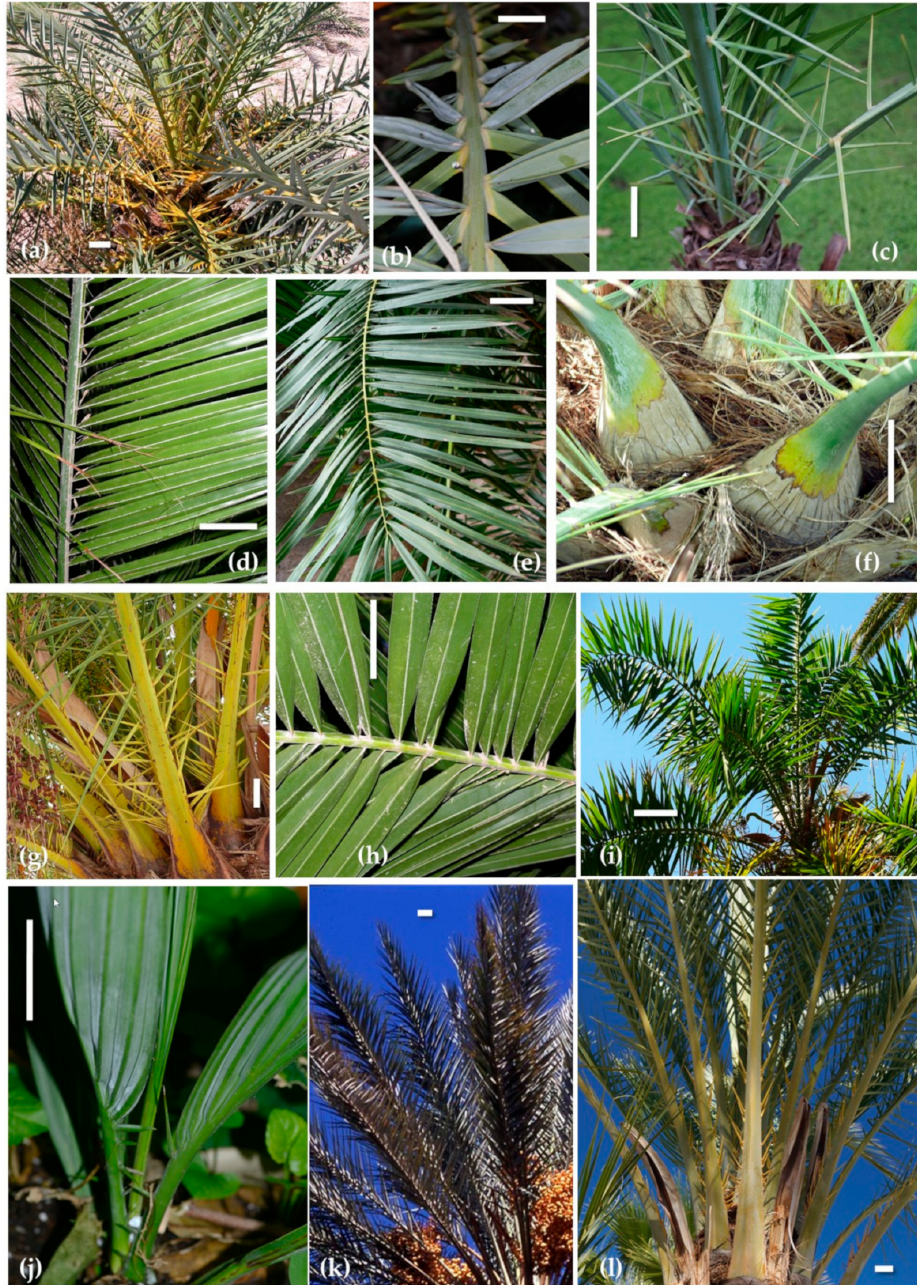
Figure 2. Diversity of Phoenix: leaves. ( a ), Phoenix theophrasti (Palmasur, Alicante, Spain); ( b ), P. iberica (Abanilla, Spain); ( c ), P. loureiroi Manipur (Huerto del Cura, Elche, Spain); ( d ), P. rupicola (Medipalm, Almer í a, Spain); ( e ) P. arabica (Djebel Bura, Yemen) ( f ), P. loureiroi var. loureiroi (Orihuela, Spain); ( g ), P. canariensis var. canariensis (Toulon, France); ( h ), P. reclinata (Medipalm, Almer í a, Spain); ( i ), P. pusilla (Menton, France); ( j ), P. paludosa (Orihuela, Spain); ( k ), P. dactylifera Eastern Group (E_DAC) (Palmyra, Syria); ( l ), P. dactylifera Western Group (W_DAC) (Jacarilla, Spain). Abbreviations for the major P. dactylifera geographical groups: E_DAC: North Africa and West Asia P. dactylifera. W_DAC: North Africa and Mediterranean P. dactylifera. Scale bar: 10 mm. Images: ( a – d , f – l ). Diego Rivera and Concepci ó n Ob ó n, ( e ). Joel